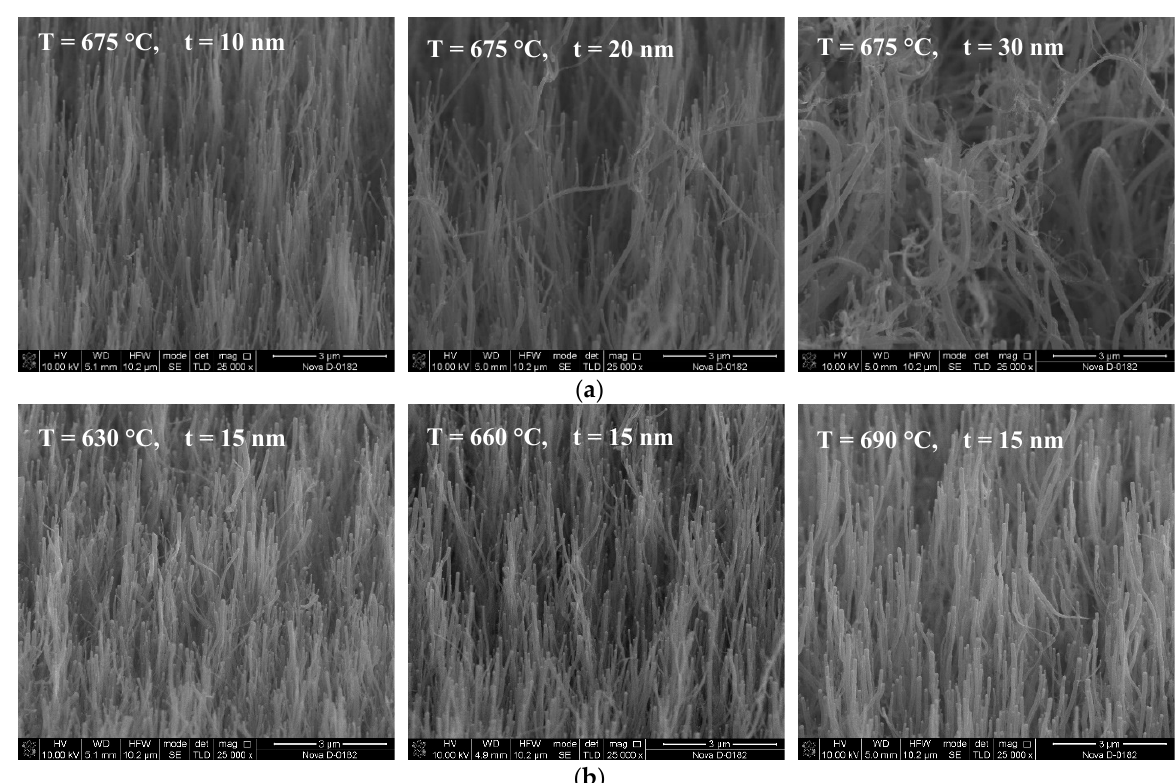
Figure 1. ( a ) SEM images of CNT arrays grown at a temperature of 675 °C and a catalytic layer thickness t ranging from 10 to 30 nm, and ( b ) at a catalytic layer thickness of 15 nm and an increase in temperature from 660 to 690 °C.